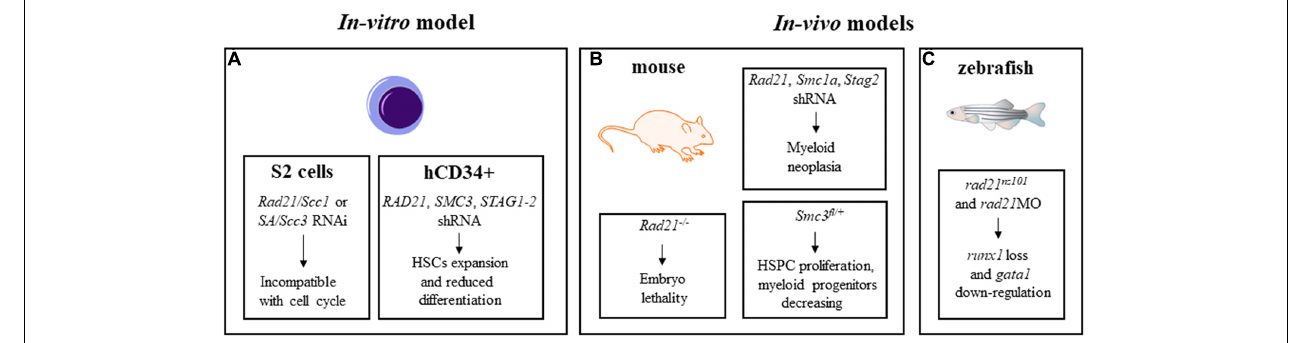
FIGURE 2 | In-vitro (A) and in-vivo (B,C) models for the study of cohesin roles in